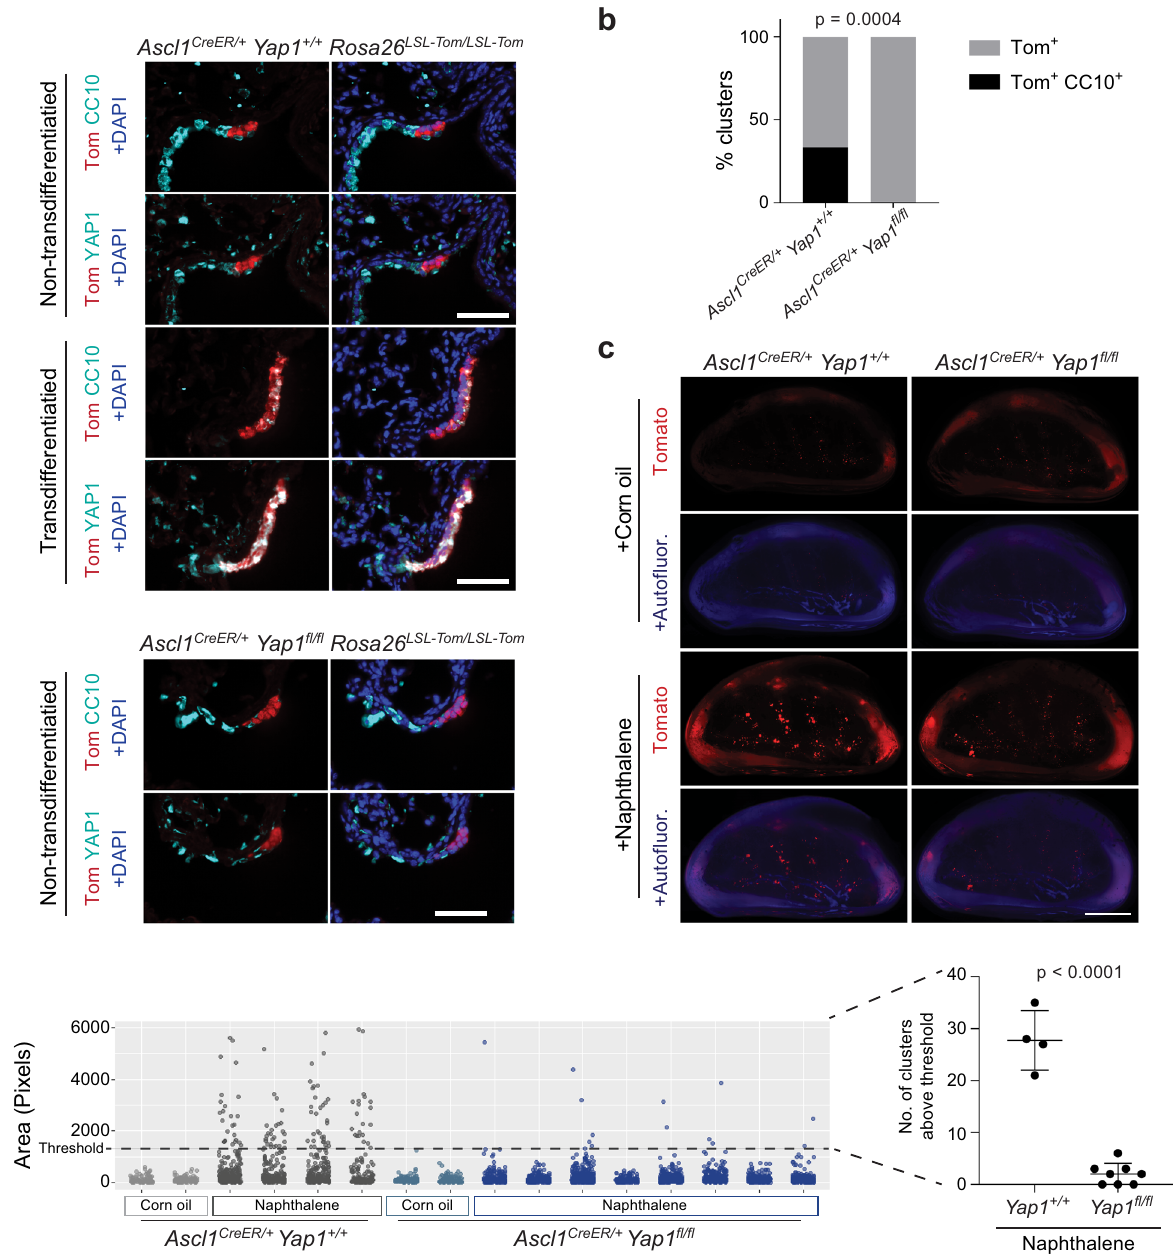
Fig. 7 YAP1 is required for the transdifferentiation of pulmonary neuroendocrine cells after naphthalene injury. a Representative immuno fl uorescence images for Tomato expression (red) and either CC10 or YAP1 (cyan) on consecutive sections from a Ascl1 CreER/ + ; Rosa26 LSL-Tom/LSL-Tom ; Yap1 + / + or Yap1 fl / fl mouse 3 weeks after naphthalene-induced lung injury and tamoxifen injection (as in Fig. 4b). DAPI stains DNA in blue in the images on the right. Scale bar, 50 μ m. b Quanti fi cation (%) of clusters that are Tom + or Tom + , CC10 + after injury as in ( a ) ( n = 27 clusters for Yap1 + / + and 32 clusters for Yap1 fl / fl counted from 3 mice per genotype). Fisher ’ s exact test, two-tailed. c Whole mount fl uorescence images of left lung lobes 3 weeks after injury. Images representative of n = 2 independent experiments. Scale bar, 5mm. d Scatterplot of normal NEBs and PNEC outgrowths after injury as in ( c ) with each column in the scatterplot representing a single mouse and each data point a tomato-positive cluster in that mouse ( n = 2 mice for corn oil controls, 4 mice for naphthalene-treated Yap1 + / + and 8 mice for naphthalene-treated Yap1 fl / fl ). Unpaired t -test was conducted on the number of clusters from each mouse in naphthalene-treated groups that are above the threshold size of the non-injured controls ( n = 4 mice for Yap1 + / + , n = 8 mice for Yap1 fl / fl ), data represented as mean±s.d. See also Supplementary Fig. 10. Source data are provided as a Source Data fi